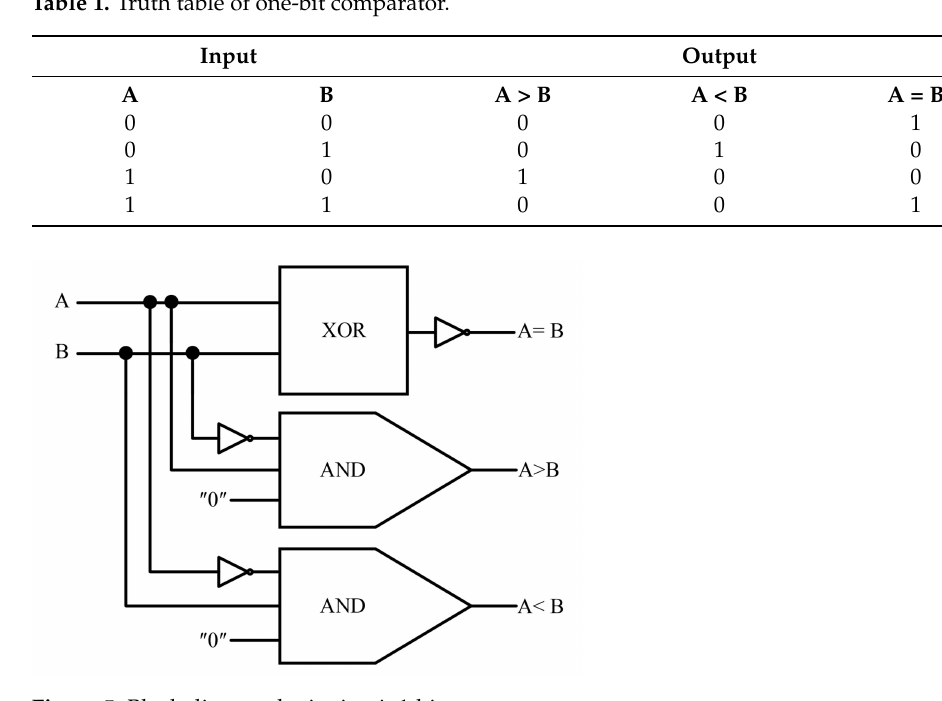
Figure 5. Block diagram logic circuit 1-bit comparator.